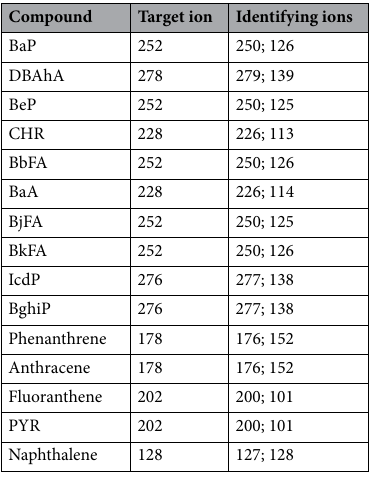
Table 2. Target and identification ions and retention times for the determined